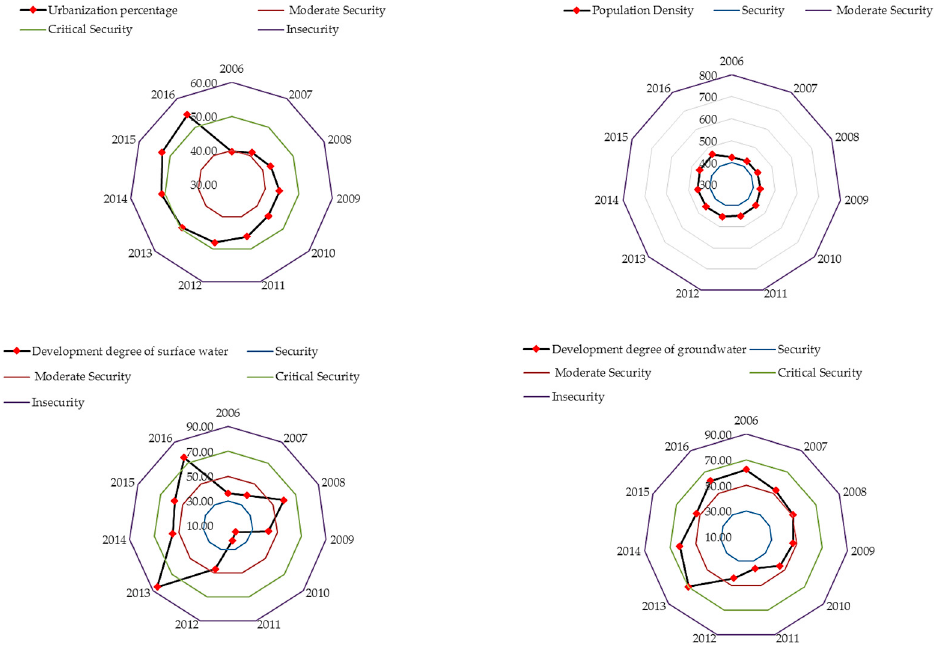
Figure 5. Negative changes of indexes in pressure subsystem from 2006 to 2016.